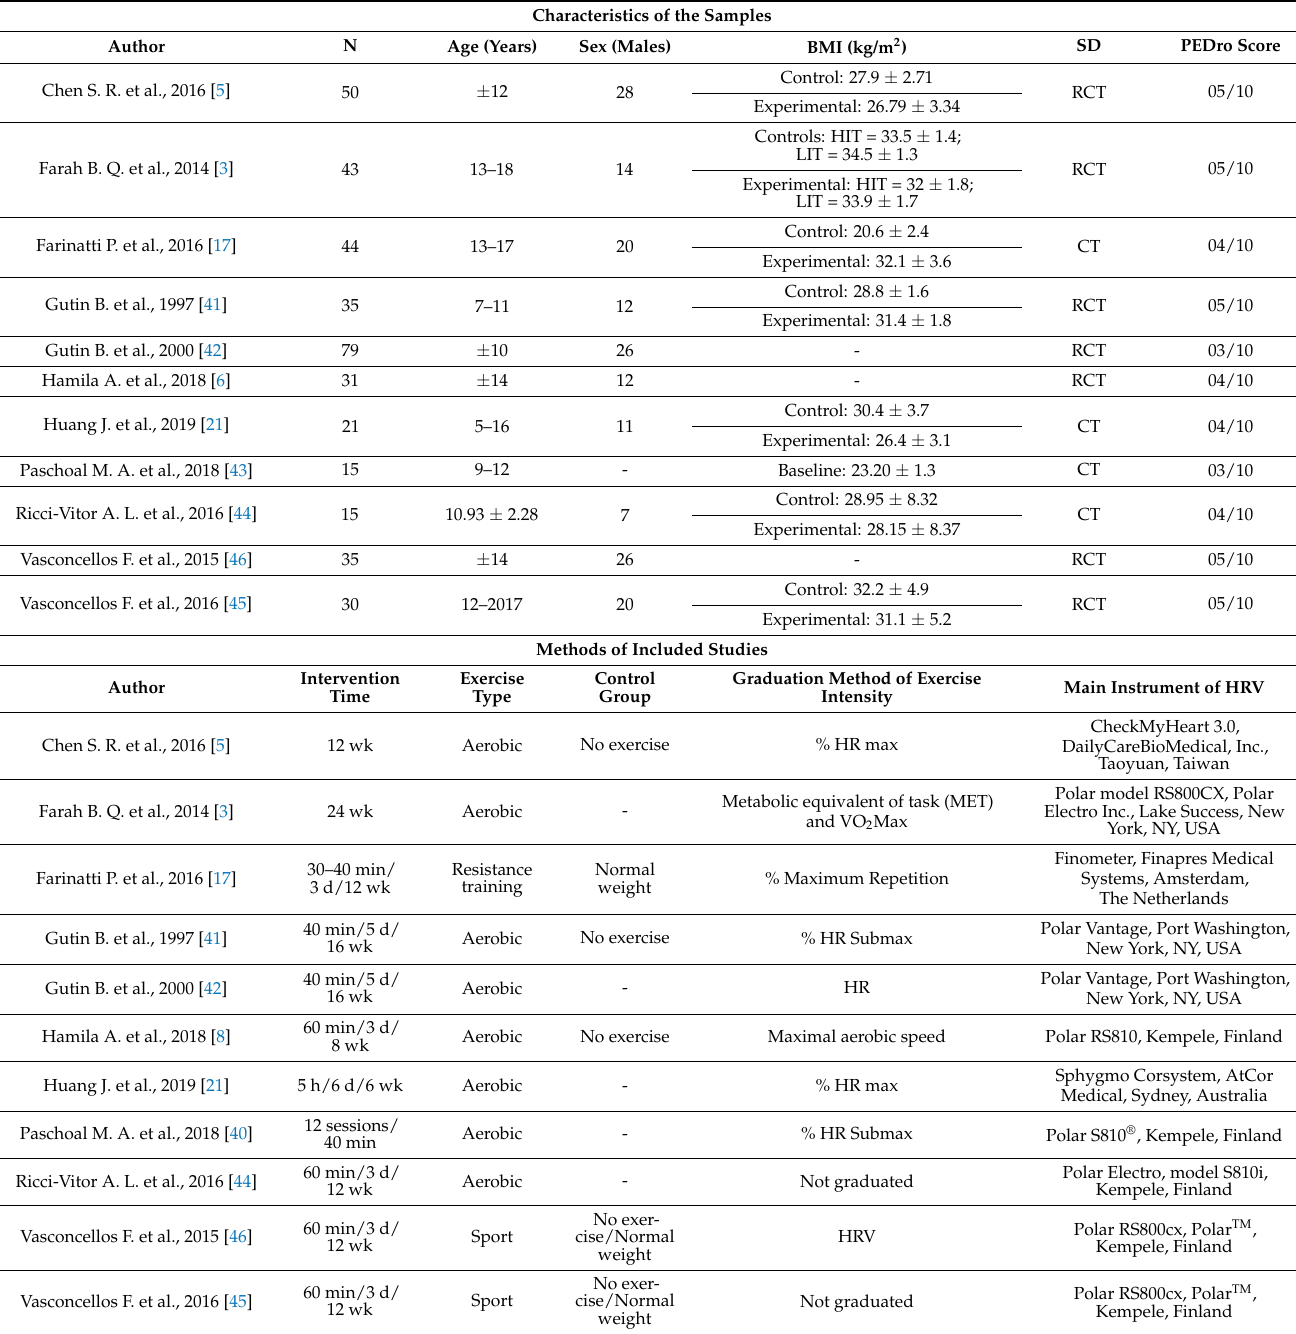
Table 1. Characteristics of the